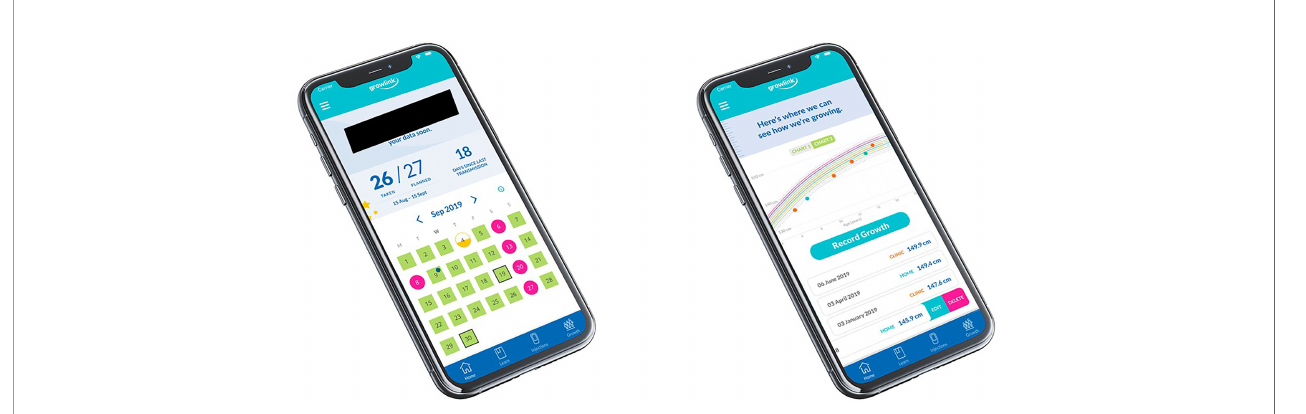
FIGURE 3 | Views of the growlink ™